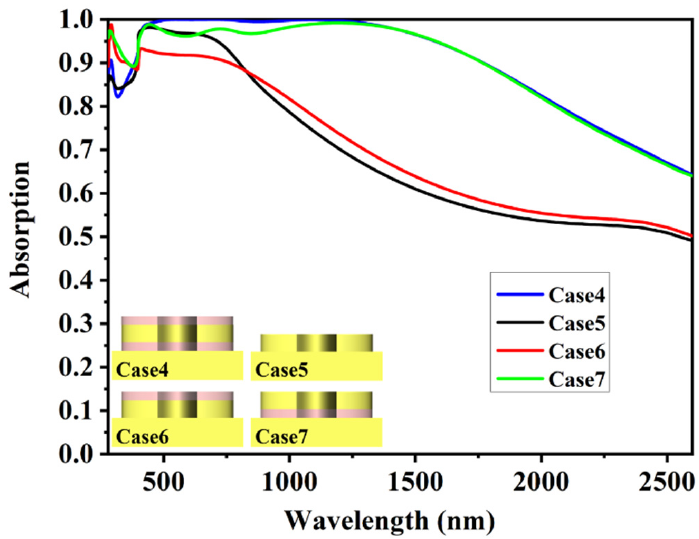
Figure 8. Absorption spectra of different layer stacking.